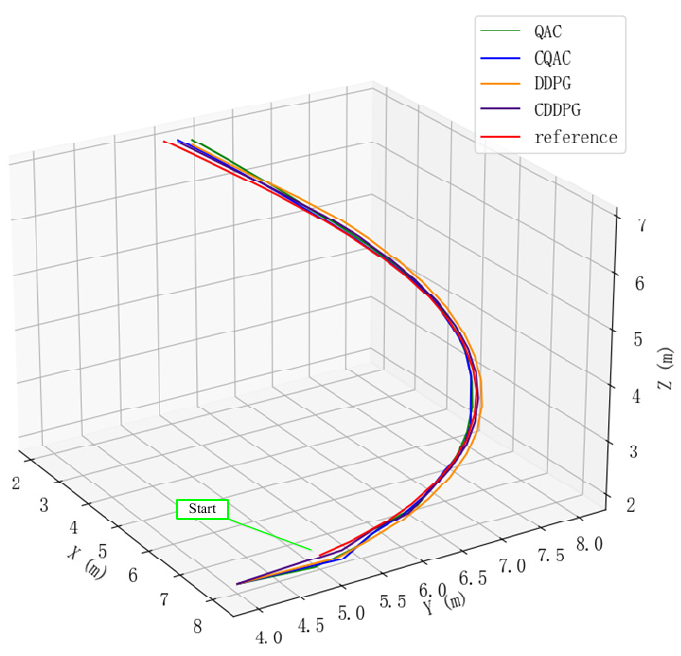
Figure 16. Spiral trajectory tracking of uniform acceleration.